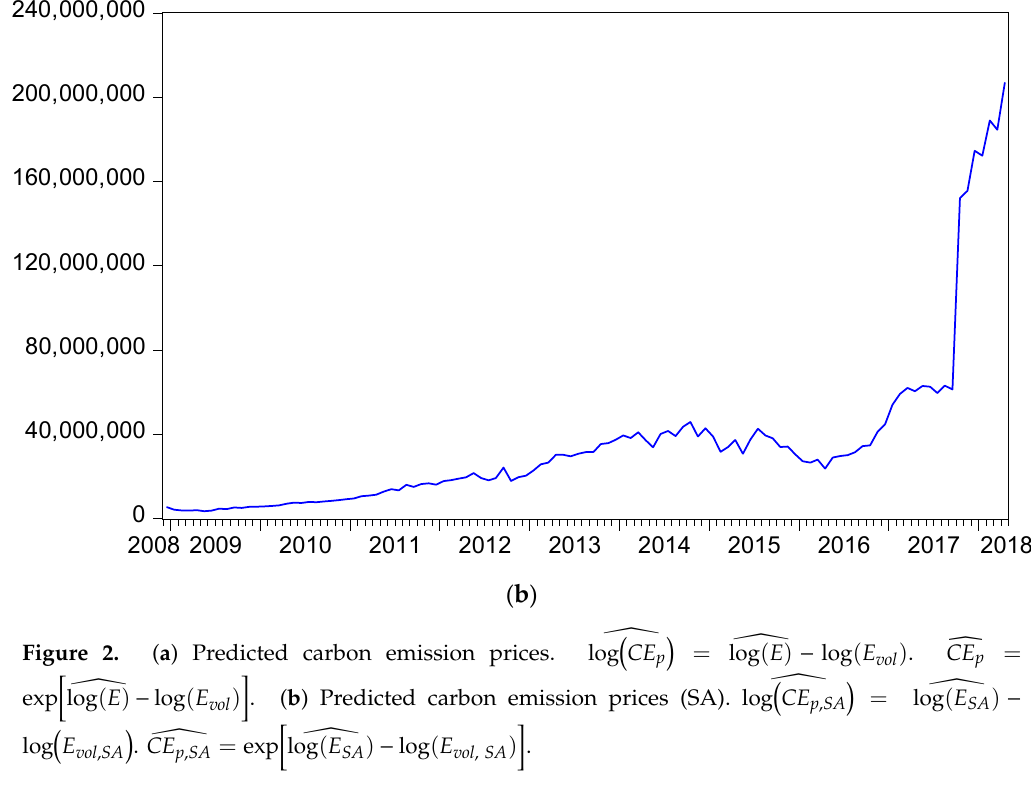
Figure 2. ( a ) Predicted carbon emission prices. 𝐥𝐨𝐠(𝑪𝑬 𝒑 )(cid:3555) = 𝐥𝐨𝐠(𝑬)(cid:3555) − 𝐥𝐨𝐠(𝑬 𝒗𝒐𝒍 ) . 𝑪𝑬 𝒑 (cid:3554) = 𝐞𝐱𝐩[𝐥𝐨𝐠(𝑬)(cid:3555) − 𝐥𝐨𝐠(𝐄 𝐯𝐨𝐥 ) ] . ( b ) Predicted carbon emission prices (SA). 𝐥𝐨𝐠(𝑪𝑬 𝒑,𝑺𝑨 )(cid:3555) = 𝐥𝐨𝐠(𝑬 𝑺𝑨 )(cid:3555) − 𝐥𝐨𝐠(𝑬 𝒗𝒐𝒍,𝑺𝑨 ) . 𝑪𝑬 𝒑,𝑺𝑨 (cid:3555) = 𝐞𝐱𝐩[𝐥𝐨𝐠(𝑬 𝑺𝑨 )(cid:3555) − 𝐥𝐨𝐠(𝑬 𝒗𝒐𝒍,𝑺𝑨 )] .